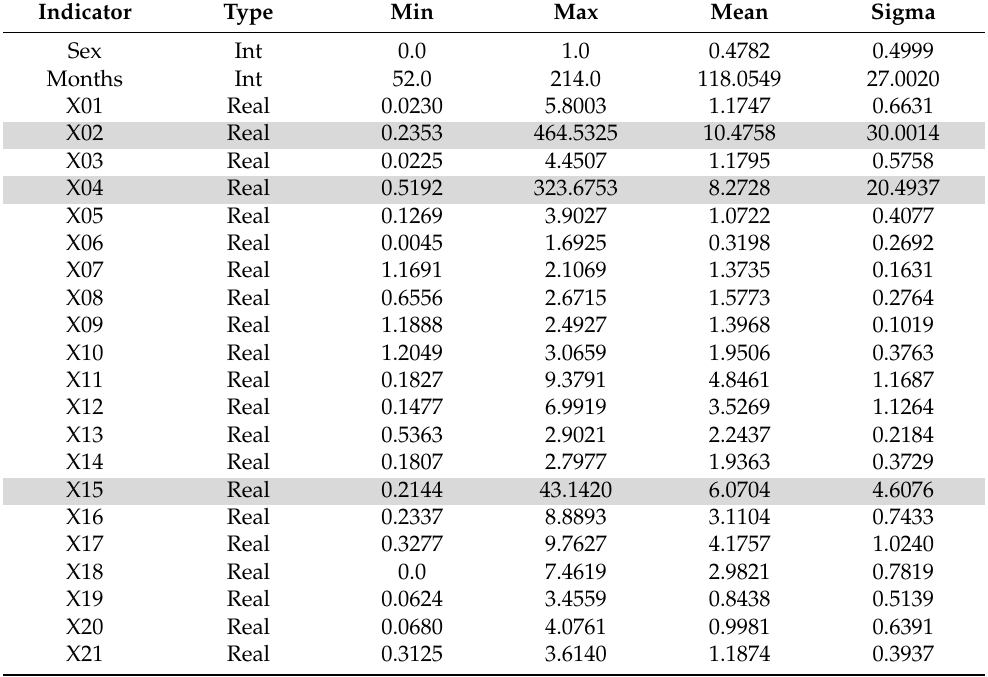
Table 9. Parameters of the generated models—prediction of age assessment.